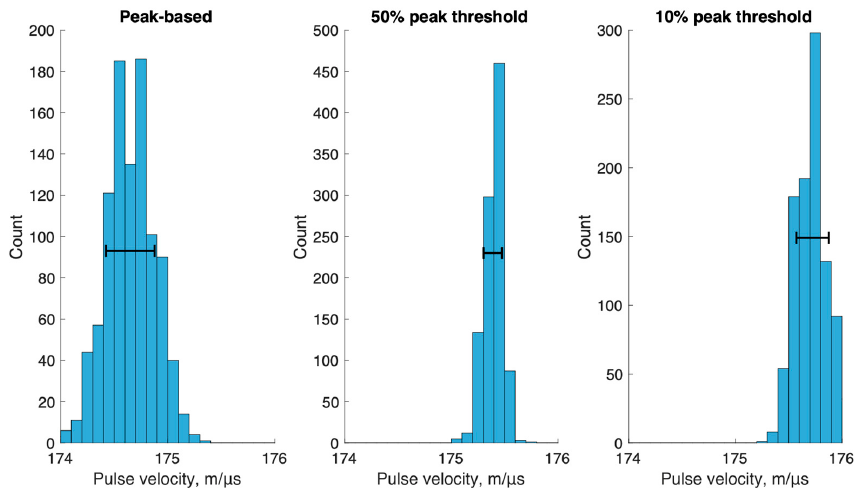
Figure 6. Pulse velocity box plots for 1 nC pulse injected at the far end of the cable, measured using HFCT.